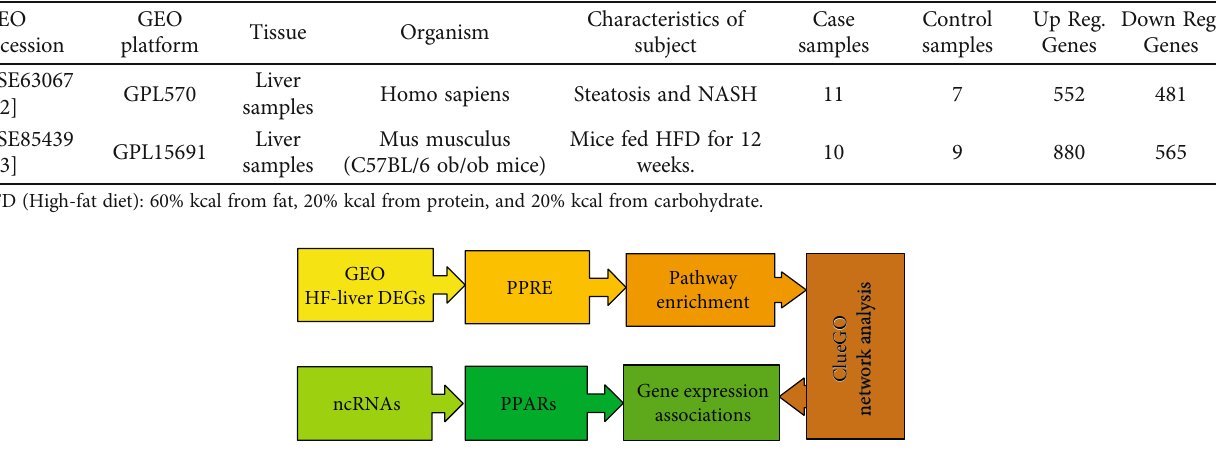
Figure 1: Flowchart of the